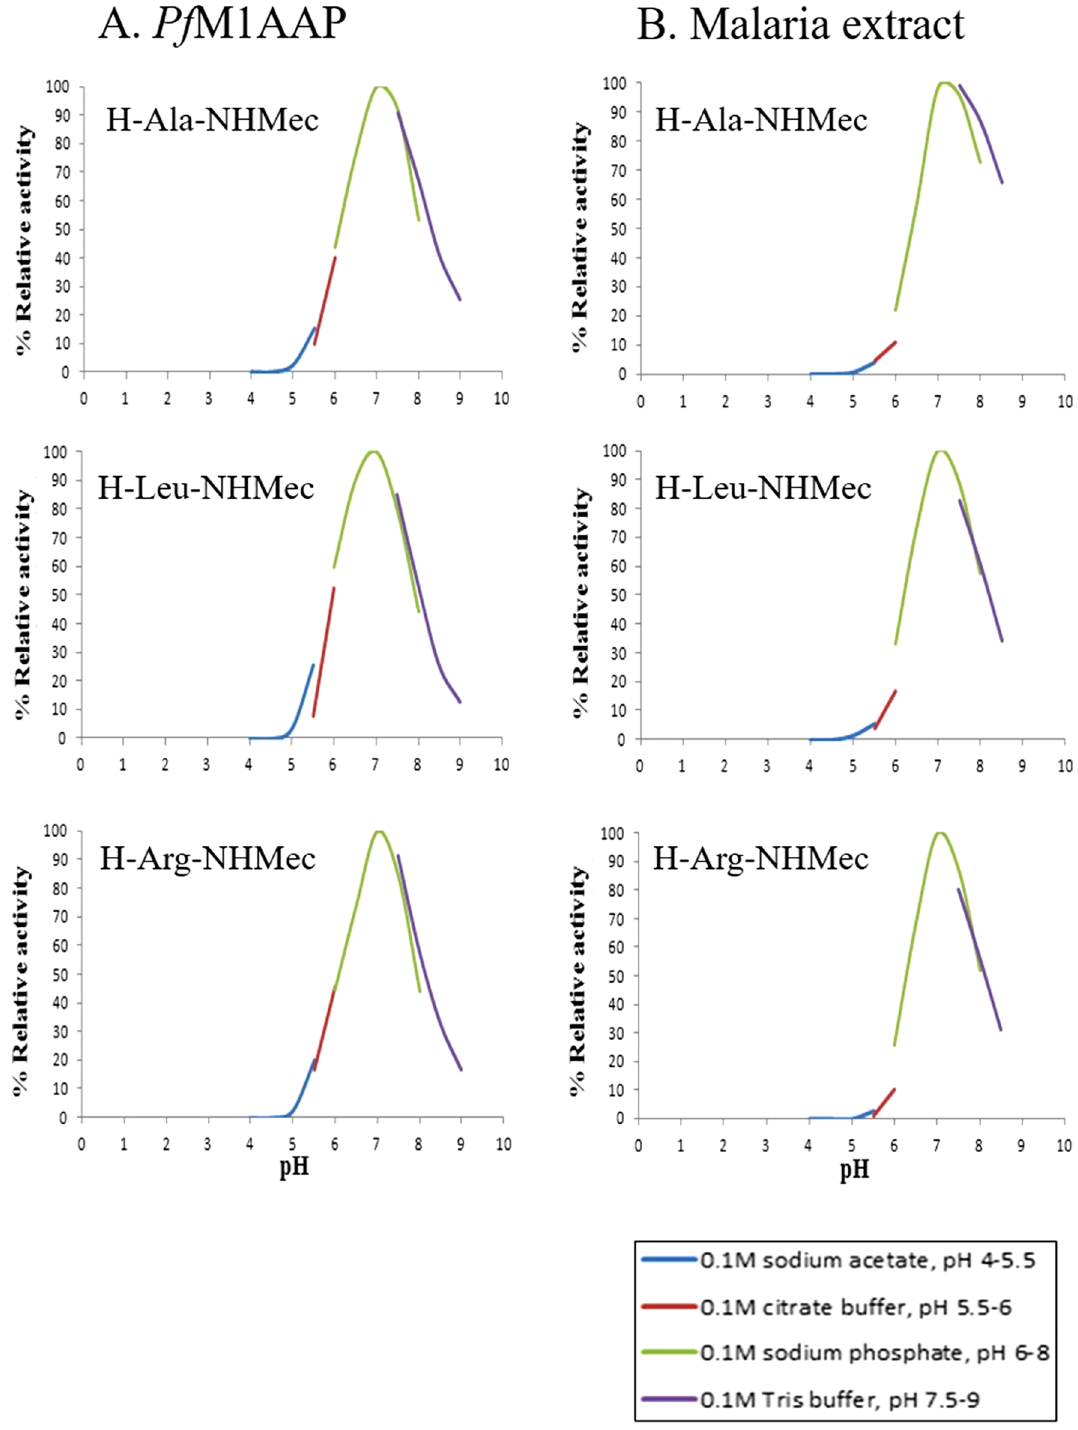
Figure 7. pH profiles of Pf M1AAP and soluble extracts of malaria parasites. Recombinant Pf M1AAP enzyme (1 μg) ( A ) or soluble extract of malaria parasites (5 μg) ( B ) was incubated in a series of pH-controlled buffers (0.1 M sodium acetate pH 5.0–5.5, 0.1 M sodium citrate pH 5.5–6.0, 0.1 M sodium phosphate pH 6.0–8.0, 0.1 M Tris buffer pH 7.5–8.5) in the presence of the fluorogenic peptide substrates H-Ala-NHMec, H-Leu-NHMec or H-Arg-NHMec. The release of the fluorophore NHMec was monitored in a fluorimeter with excitation at 360 nm and emission at 460 nm. Reaction rates were used to plot pH-activity